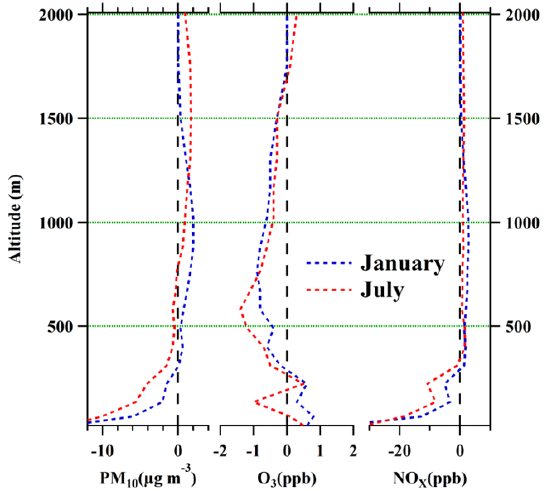
Figure 13. The vertical profiles of monthly averaged differences for PM 10 , NO x and O 3 between ADDAH and NONAH (ADDAH- NONAH) over